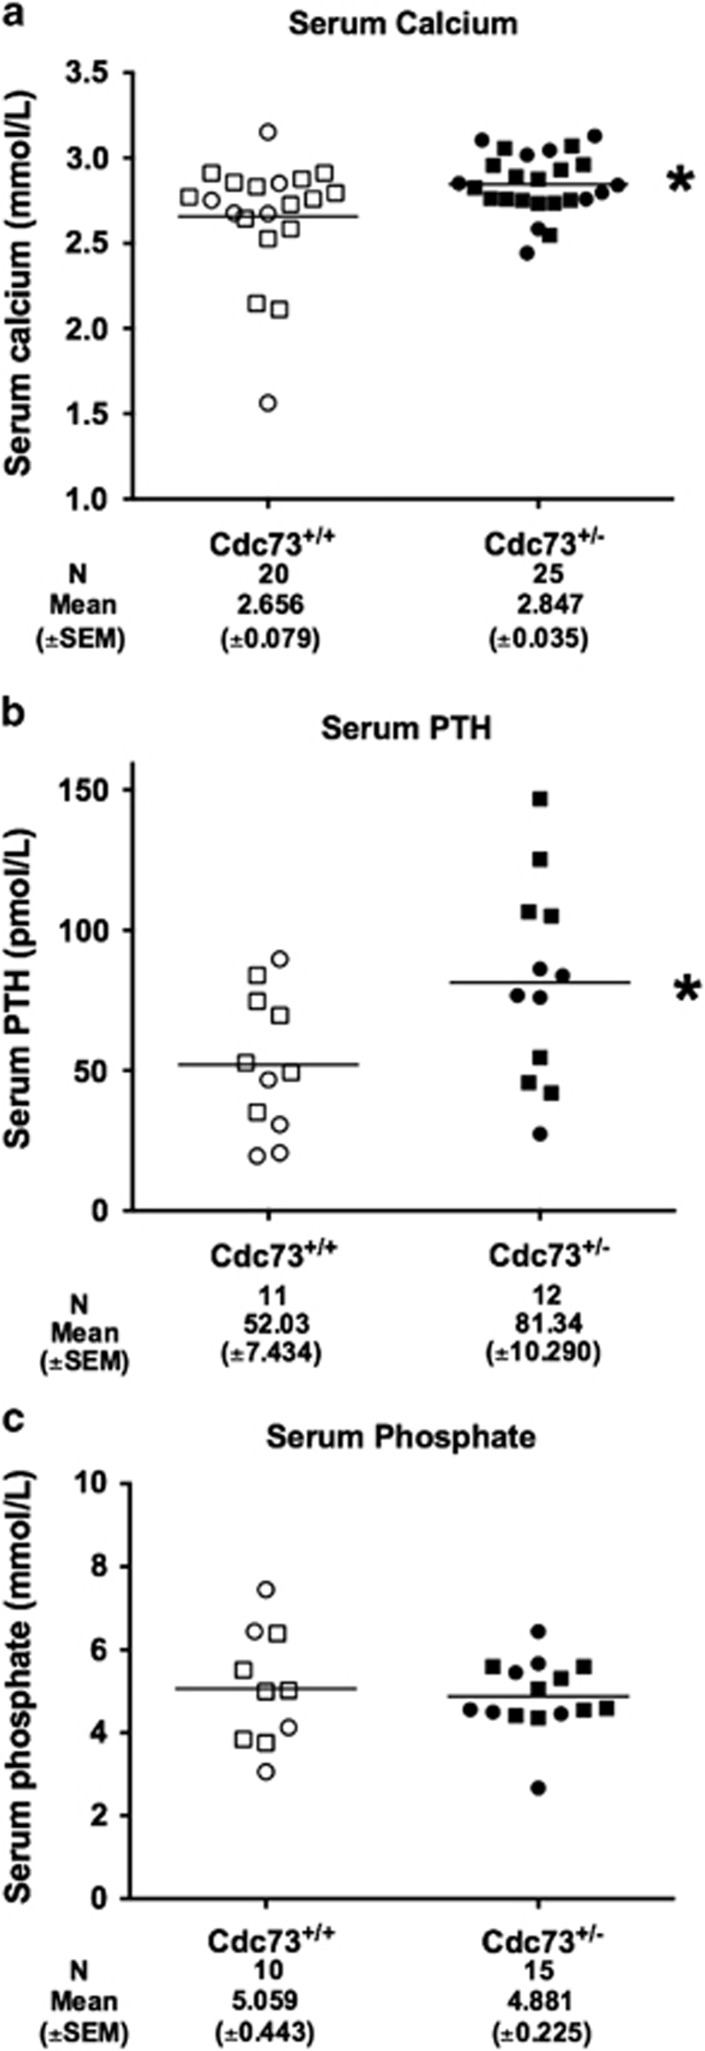
Cdc73+/− mice have increased mean serum calcium and PTH concentrations, when compared to Cdc73+/+ mice. (a) Serum calcium concentration, adjusted for albumin concentration, revealed an increased mean serum calcium concentration in Cdc73+/− mice with parathyroid tumours when compared to Cdc73+/+ littermates with normal parathyroids (*P<0.05). (b) Mean serum PTH concentration was elevated in Cdc73+/− mice with parathyroid tumours compared to Cdc73+/+ littermates with normal parathyroids (*P<0.05). (c) Serum phosphate concentration in Cdc73+/− mice with parathyroid tumours compared to Cdc73+/+ littermates with normal parathyroids. Cdc73+/− mice with parathyroid tumours are shown as filled symbols and Cdc73+/+ littermates with normal parathyroids are shown as open symbols. Squares represent males and circles represent females. The age range of the mice was 17–24 months (mean±s.e.m.=20.0±0.30). Combined results from males and females for serum calcium, phosphate and PTH concentrations are shown, as there were no significant gender differences. Horizontal lines indicate mean values together with the standard error of the mean (s.e.m.), which is shown numerically below each group and the number (N) of mice.